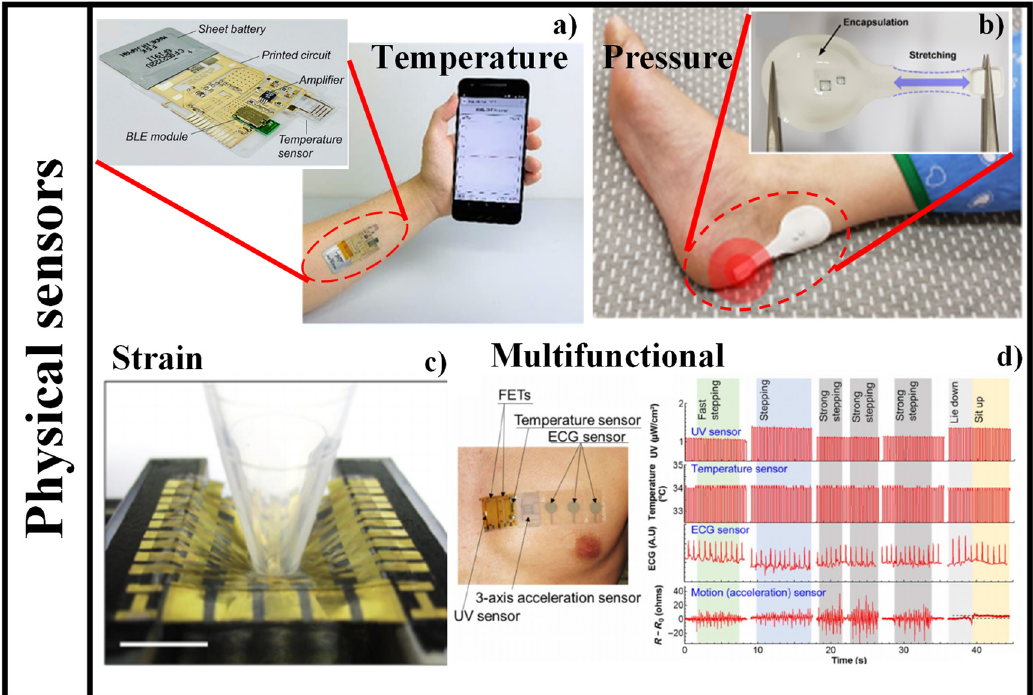
Figure 12. Different applications of flexile physical sensing devices, ( a ) graphical illustration of wireless sensing platform affixed to an arm for real-time body temperature tracking. Inset shows the optical image of the wireless temperature sensing platform with printed temperature sensing device [161], ( b ) photograph of a device affixed to body heel that is susceptible to pressure. Inset shows the photograph of a battery-free, wireless pressure sensing device [165], ( c ) photograph of strain-sensitive elastic active-matrix transistor array as skin-like elastic strain sensing device [166], ( d ) image of the multifunctional device attached directly onto the skin ( left ) real-time acceleration (motion), ECG, skin temperature, and UV tracking results